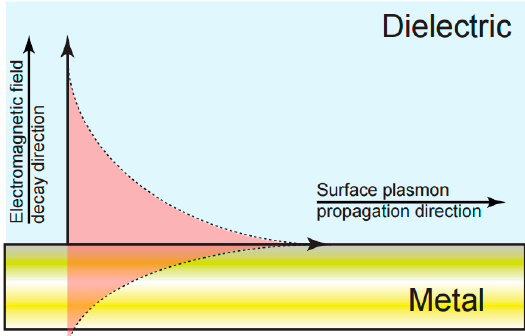
Figure 2. Schematic of surface plasmon resonance (SPR) field distribution at a metal-dielectric interface. The overlap of the evanescent field with the dielectric phase of the interface provides a direct measurement of changes in the local refractive index.